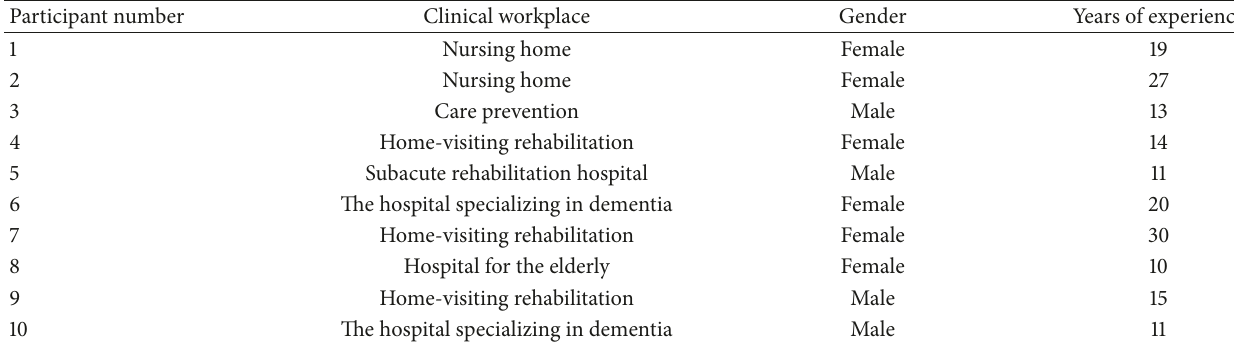
Table 1: Participant